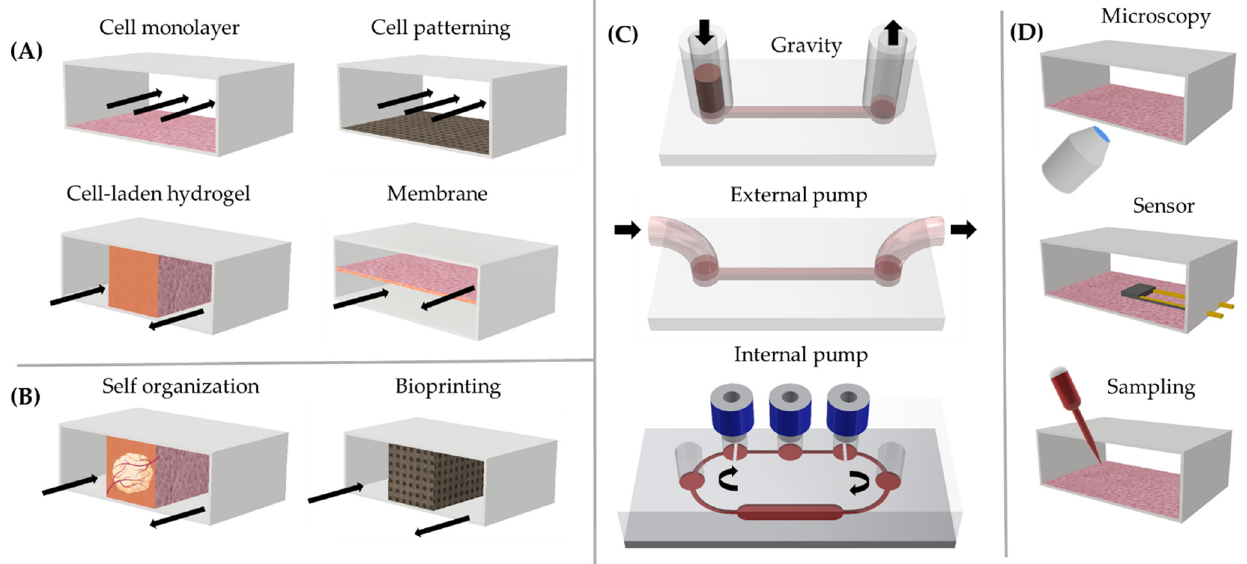
Figure 1. Main components of current OoC systems: ( A ) non-3D models, ( B ) 3D models, ( C ) perfusion modes, and ( D ) readouts.